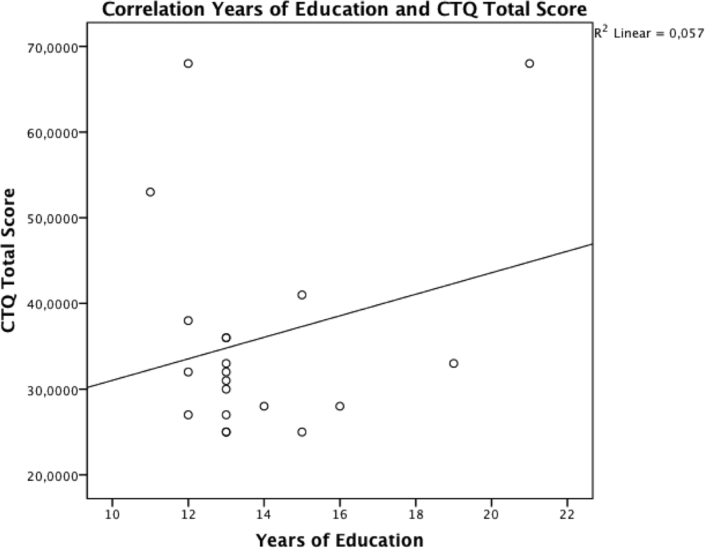
Scatterplot 3: Correlation between Years of Education and CTQ Total Score.